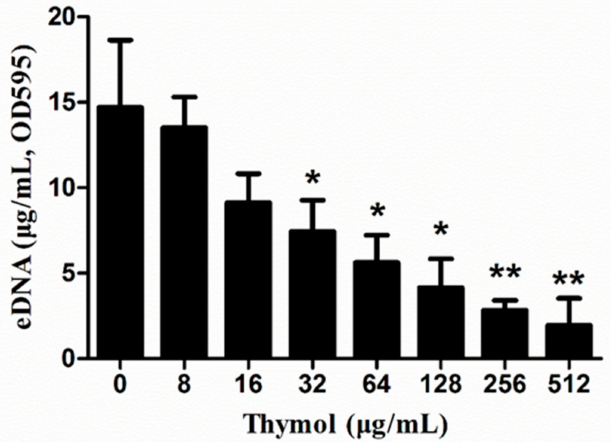
Figure 5. The e ff ects of thymol on eDNA release by TCH1516 biofilms. * p < 0.05 or ** p < 0.01, compared with the 0 µ g / mL